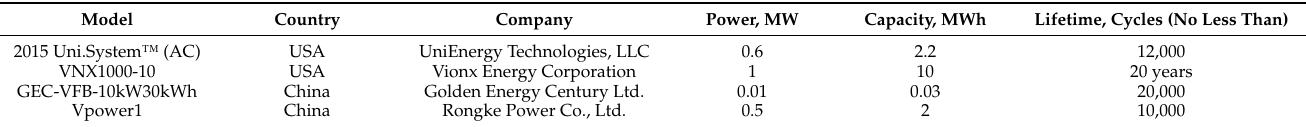
Table 2. Parameters of commercially available flow